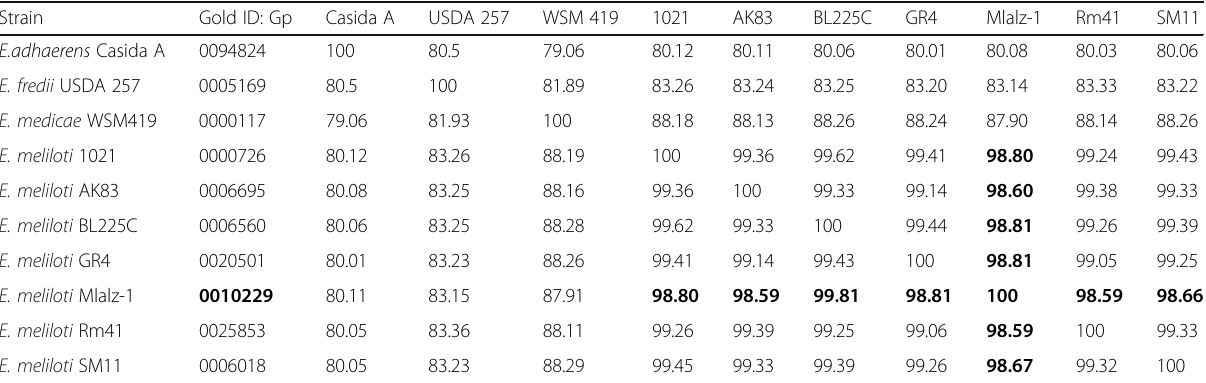
For E. meliloti Mlalz-1, gANI values above the microbial species delineation cutoff value of 96.5% [39] are in bold